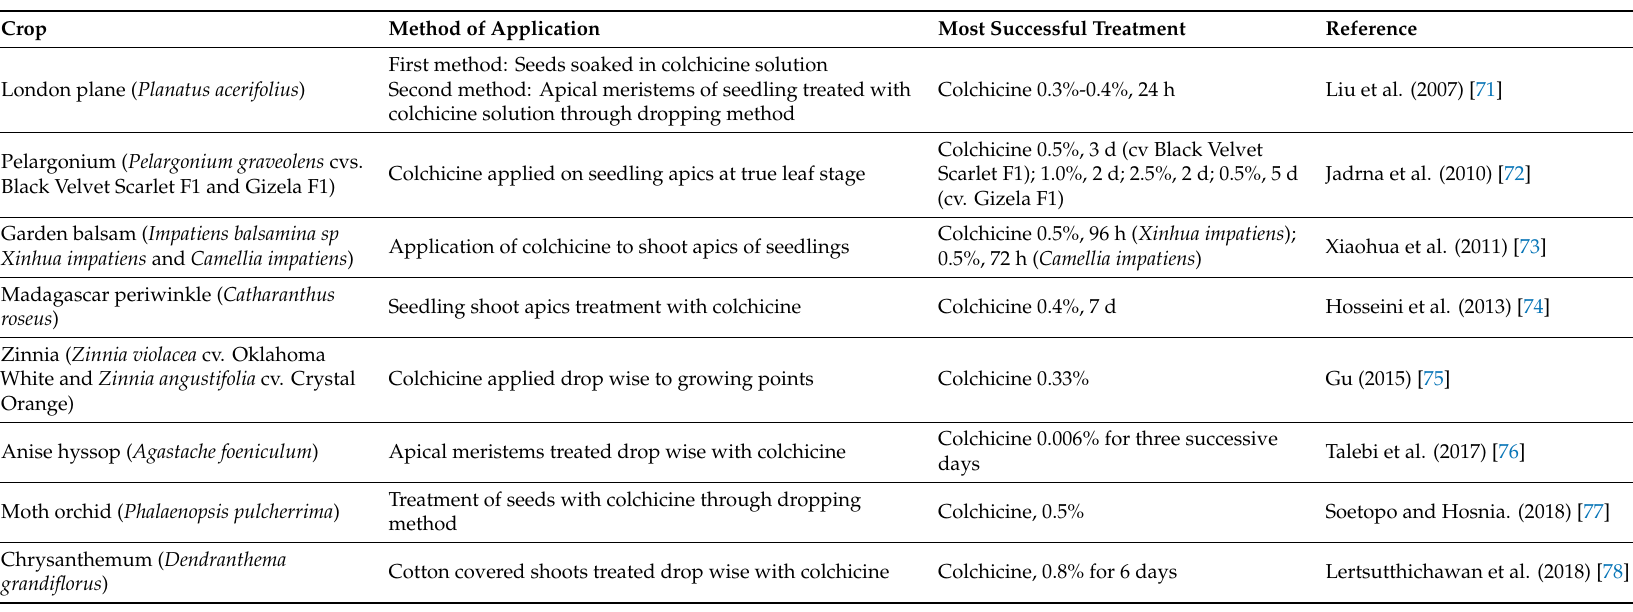
Table 4. Induction of polyploidy in ornamental plants by applying colchicine through dropping method since last fifteen